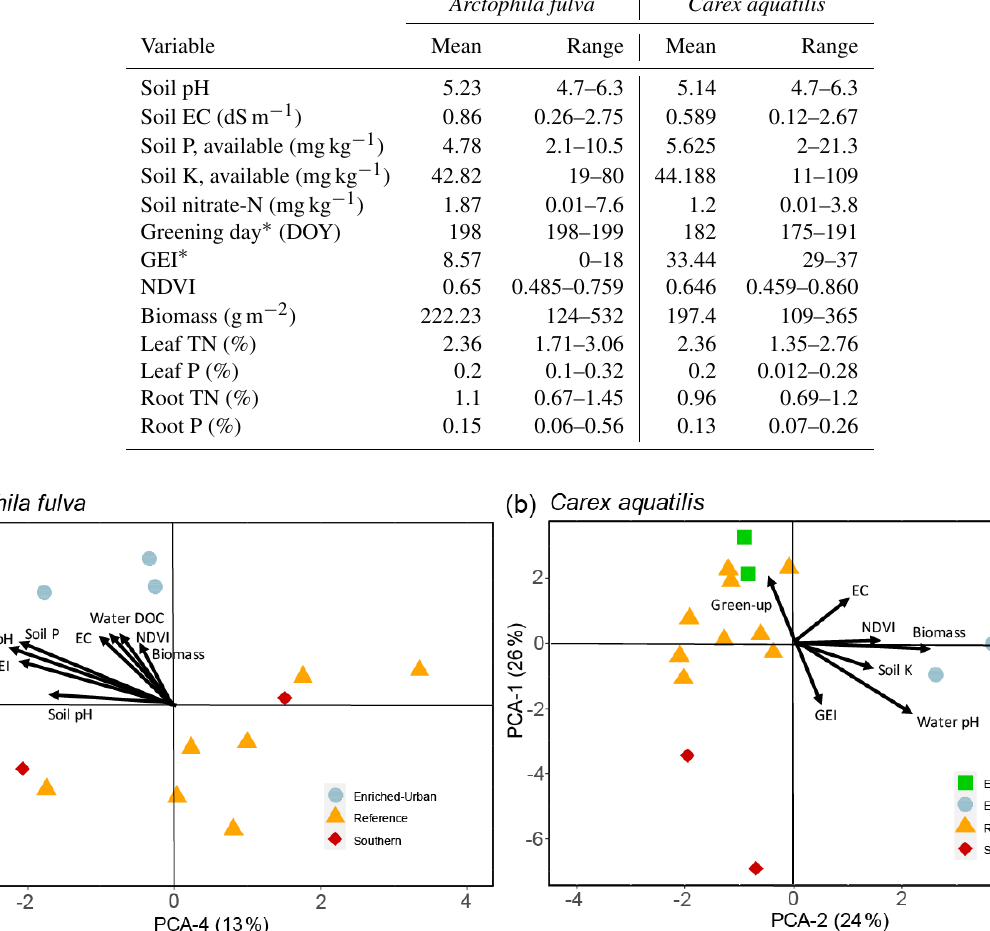
Figure 5. Plots of PCA site scores for Arctophila fulva (a) and Carex aquatilis (b) plant nutrient data. Eigenvectors depict PCA axis correlations with environmental variables. Eigenvectors are scaled for